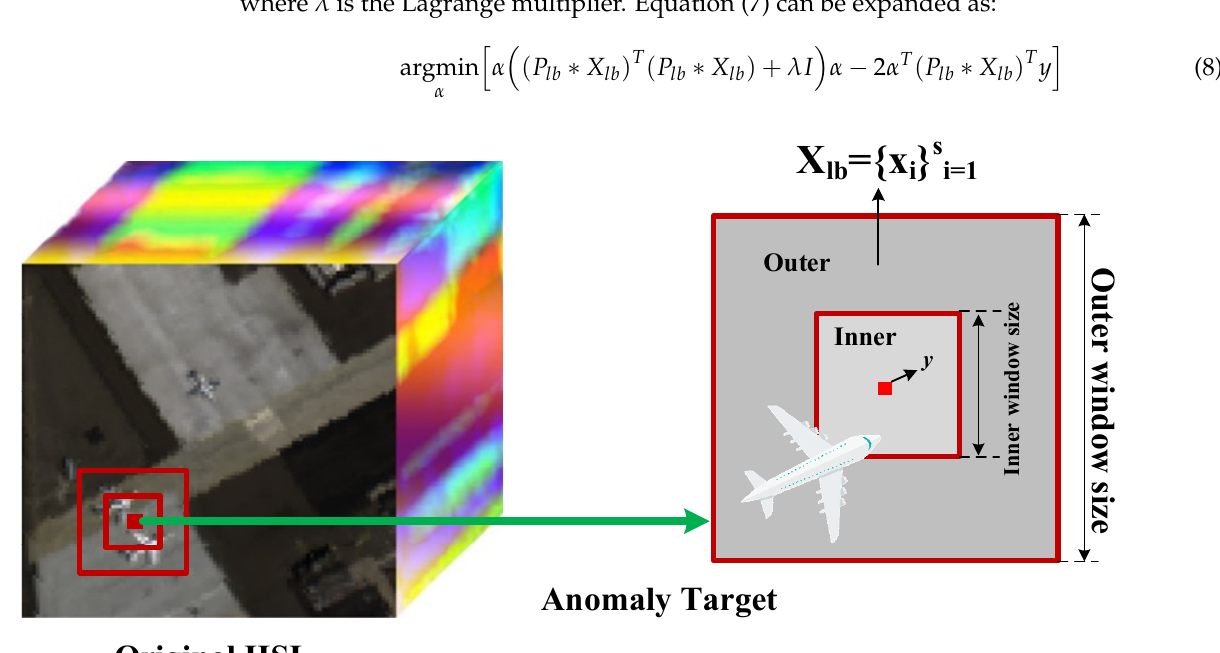
Figure 1. Sketch of the dual-window in CRD with the San Diego-II data set. Some aircraft pixels in the image may fall into the outer window.